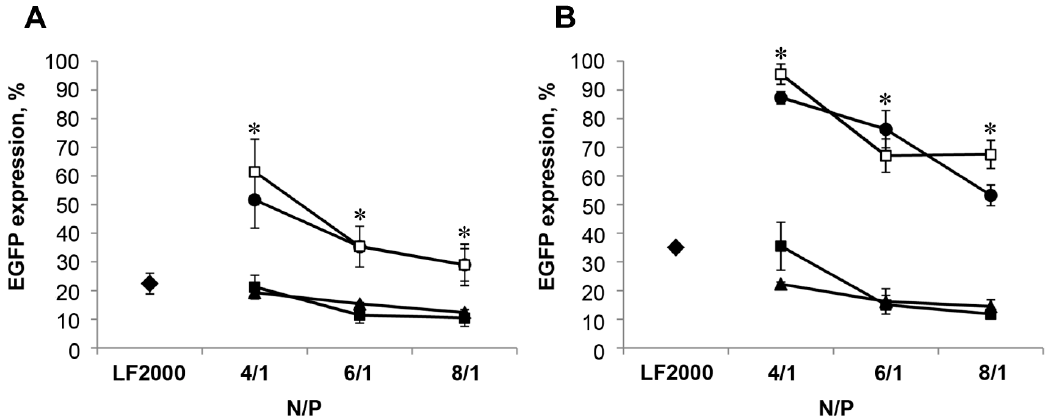
Figure 2. Silencing of EGFP gene expression in BHK IR780 cells by siEGFP delivered by cationic liposomes in serum-free conditions ( A ) or in the presence of 10% FBS ( B ). The cells were incubated with the lipoplexes formed by cationic liposomes ( ■ for L, ▲ for P800 , ● for P1500 and □ for P2000 ) and siEGFP (50 nM) at various N/P ratios. The levels of EGFP expression in the cells were evaluated using flow cytometry after 72 h of incubation with the lipoplexes. Levels of EGFP expression in the control cells (without any treatment) was set at 100%. The differences between mean values for L and other preparations at the same N/P were considered statistically significant: * p < 0.01 (Mann-Whitney U-test). siEGFP delivery by Lipofectamine 2000 ( ♦ for LF2000 ) (under optimal conditions) was used as a positive control.